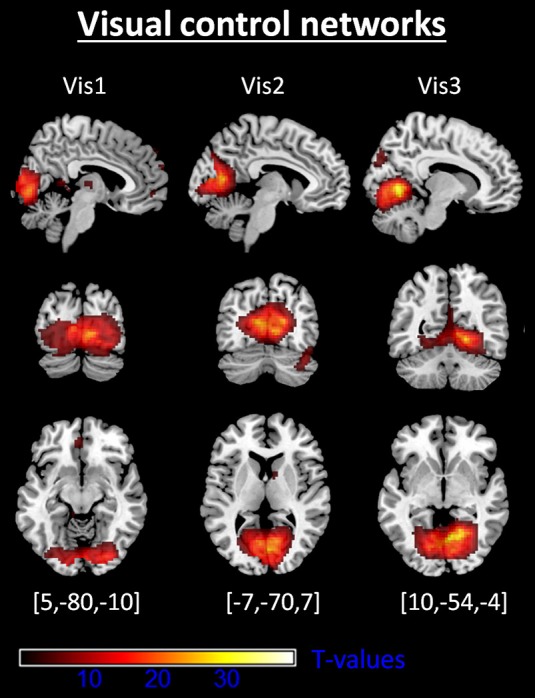
Intrinsic visual control networks. Shown are spatial maps of one-sample t-tests (voxel wise family wise error corrected, p < 0.05). Abbreviations: Vis1, visual network 1; Vis2, visual network 2; Vis3, visual network 3. coordinates are given with respect to Montreal Neurological Institute standard space.